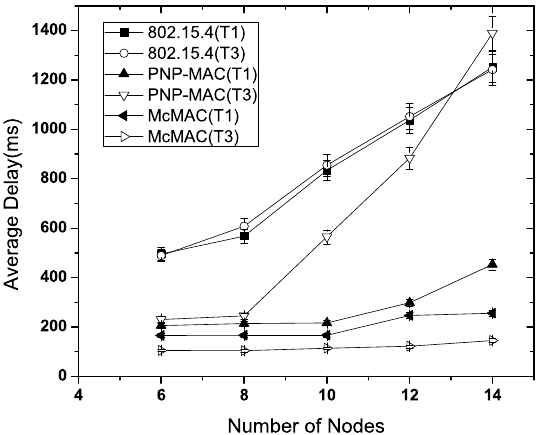
Figure 7. Average latency at varying number of nodes with emergency